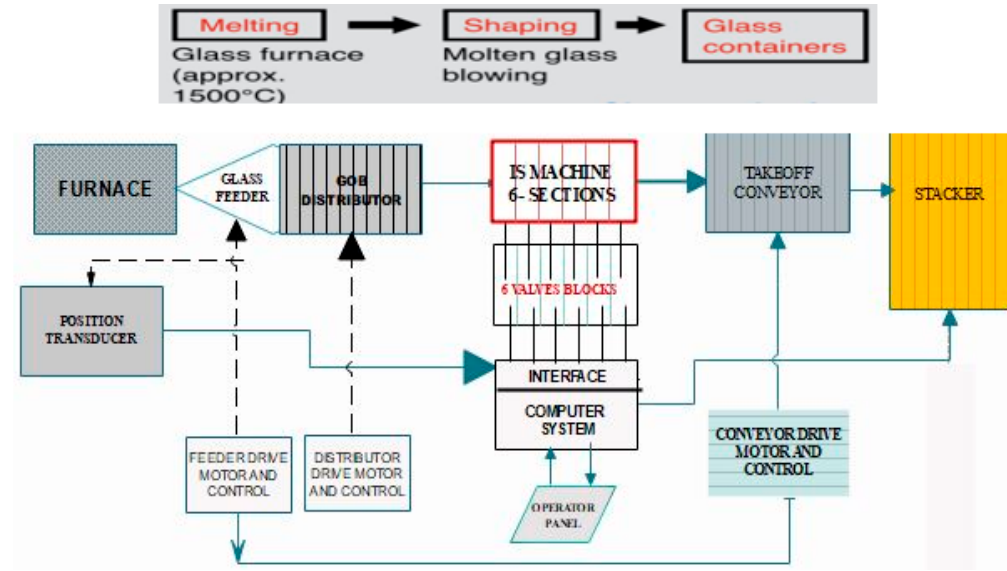
Figure 1. Process flow chart of a typical individual section-forming machine (ISM) [12].